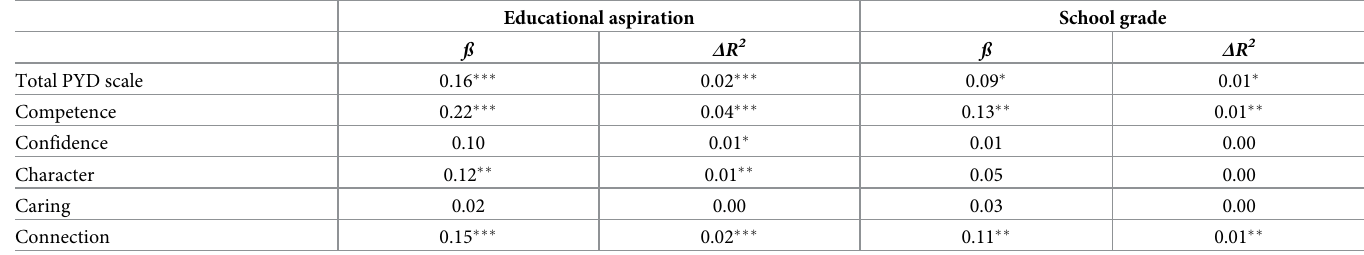
Table 4. OLS regression coefficients of total PYD scale on educational aspiration and school